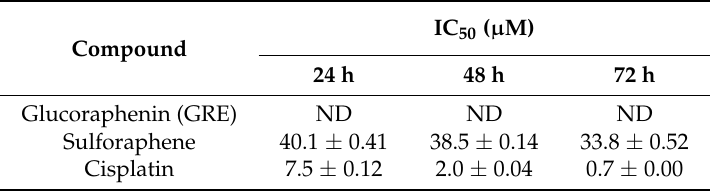
Table 1. Cytotoxicity of GRE, sulforaphene and cisplatin in HepG2